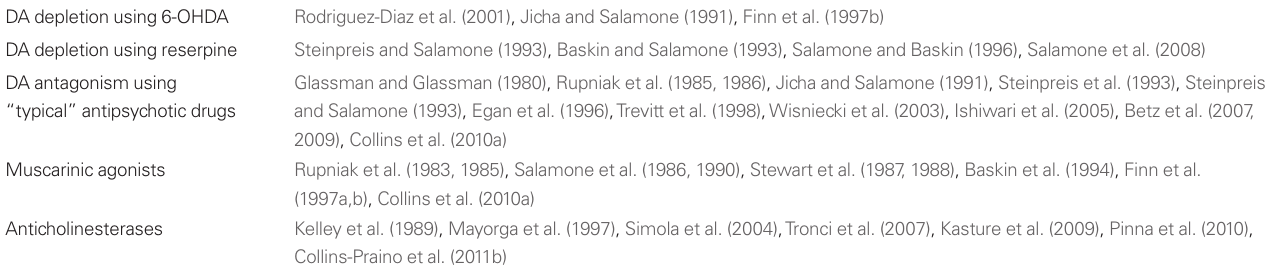
Table 1 | Neurochemical and pharmacological conditions that induce TJMs.